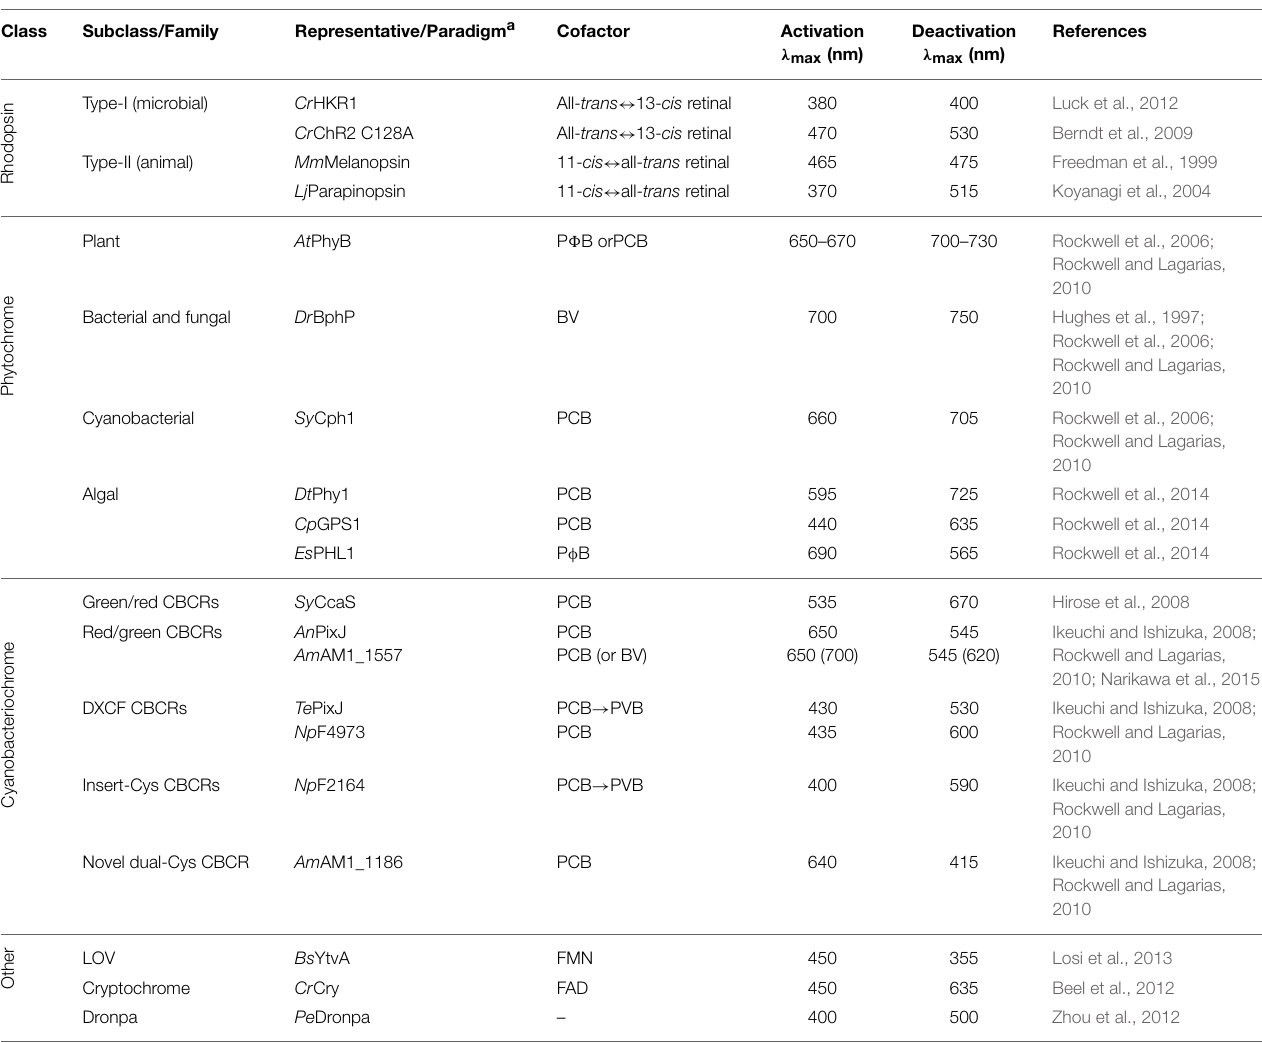
TABLE 3 | Photochromic